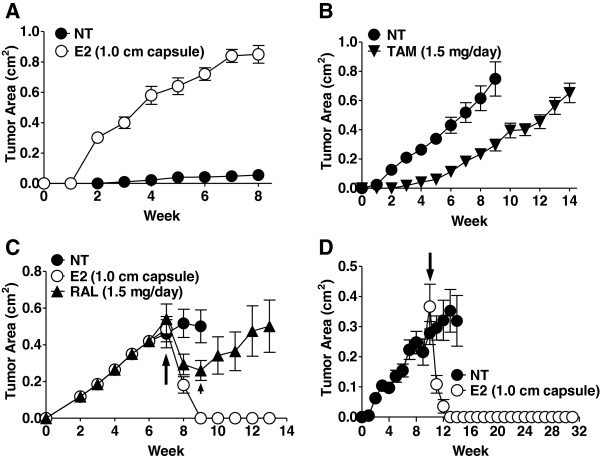
Growth of T47D:A18/neo and T47D:A18/PKCα xenograft tumors. Xenograft tumors were formed as described in materials and methods. A. T47D:A18/neo tumors (NT, 15 mice/group and E2, 3 mice/group). B. T47D:A18/PKCα tumors (10 mice/group). C. T47D:A18/PKCα tumors. Tumors were grown to an average size of 0.5 cm2. Mice were then randomized into NT, RAL or E2 groups (large arrow, 9 mice/group). Two weeks later RAL treatment was stopped (small arrow). D. T47D:A18/PKCα tumors (5 mice/group). Tumors were grown to an average size of 0.3 cm2. Mice were then randomized into NT or E2 groups (arrow).